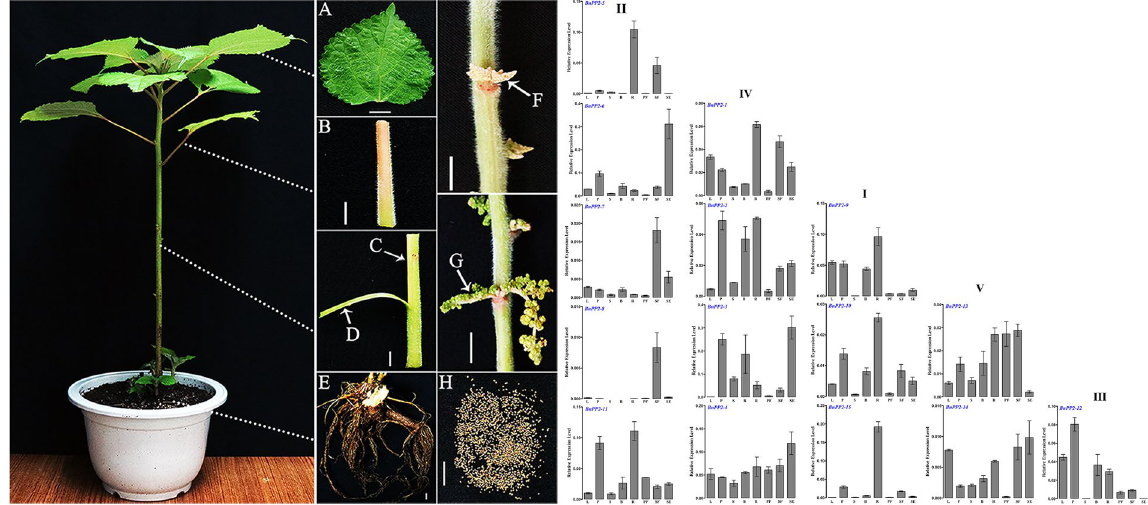
Figure 3. The diagram of eight different tissues or organs for RNA extraction in ramie (Left). ( A–H ) represented leaf (without main vein), petiole, stem, bark, root, pistillate flower, staminate flower and seed, respectively. C, D, F, and G were indicated by white arrows in this figure. Bar = 1 cm. Tissue-specific expression patterns of BnPP2 genes (Right). The BnPP2 genes were classified according to phylogenetic relationship (Fig. 1A). RNA was extracted from eight different tissues or organs of ramie and used for cDNA synthesis. L, leaf without main vein; P, petiole; S, stem; B, bark; R, root; PF, pistillate flower; SF, staminate flower; SE, seed. The data were presented as the mean ± SD of three separate measurements.